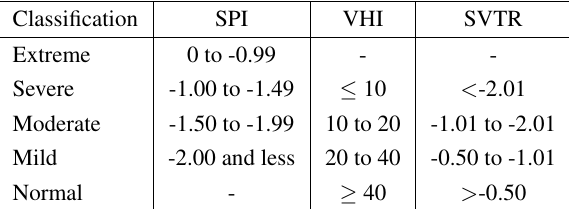
Table 2. Drought classification based on SPI (McKee et al., 1993), VHI (Kogan, 1990), and SVTR values (Perez et al.,